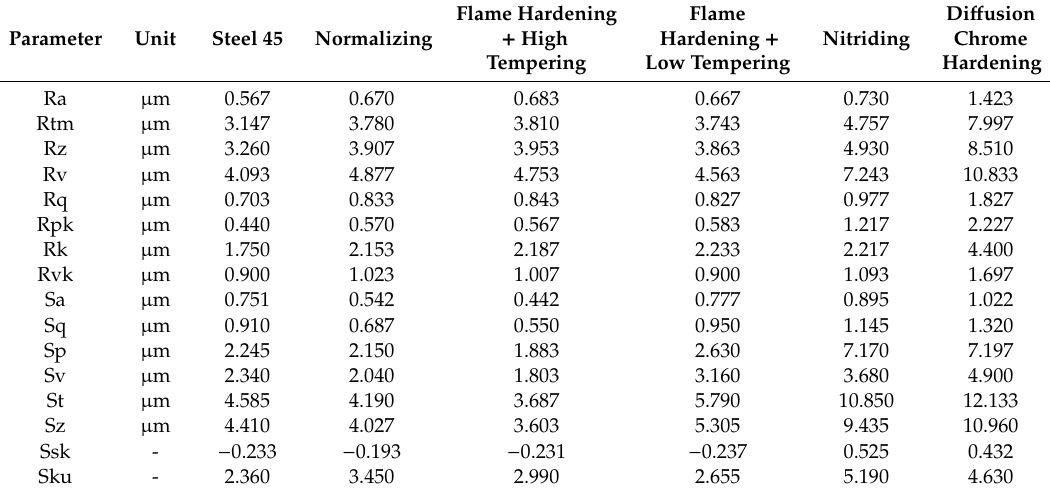
Figure 10. View of the geometric structure for flame hardening + high tempering. Table 9. The average results of surface roughness measurements before the wear test.